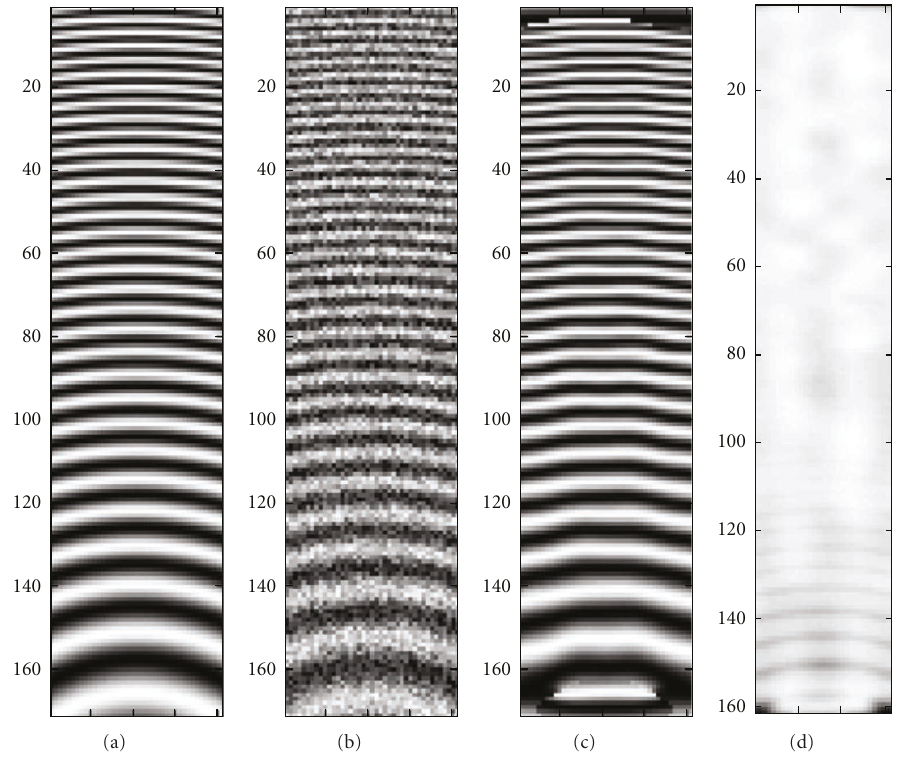
Figure 10: Results using uniform wavelength spacing filterbank specifications: (a) Input chirp image. (b) Noisy Image. (c) FM Image. (d) SSIM map between the input and filtered image. The mean SSIM was found to be